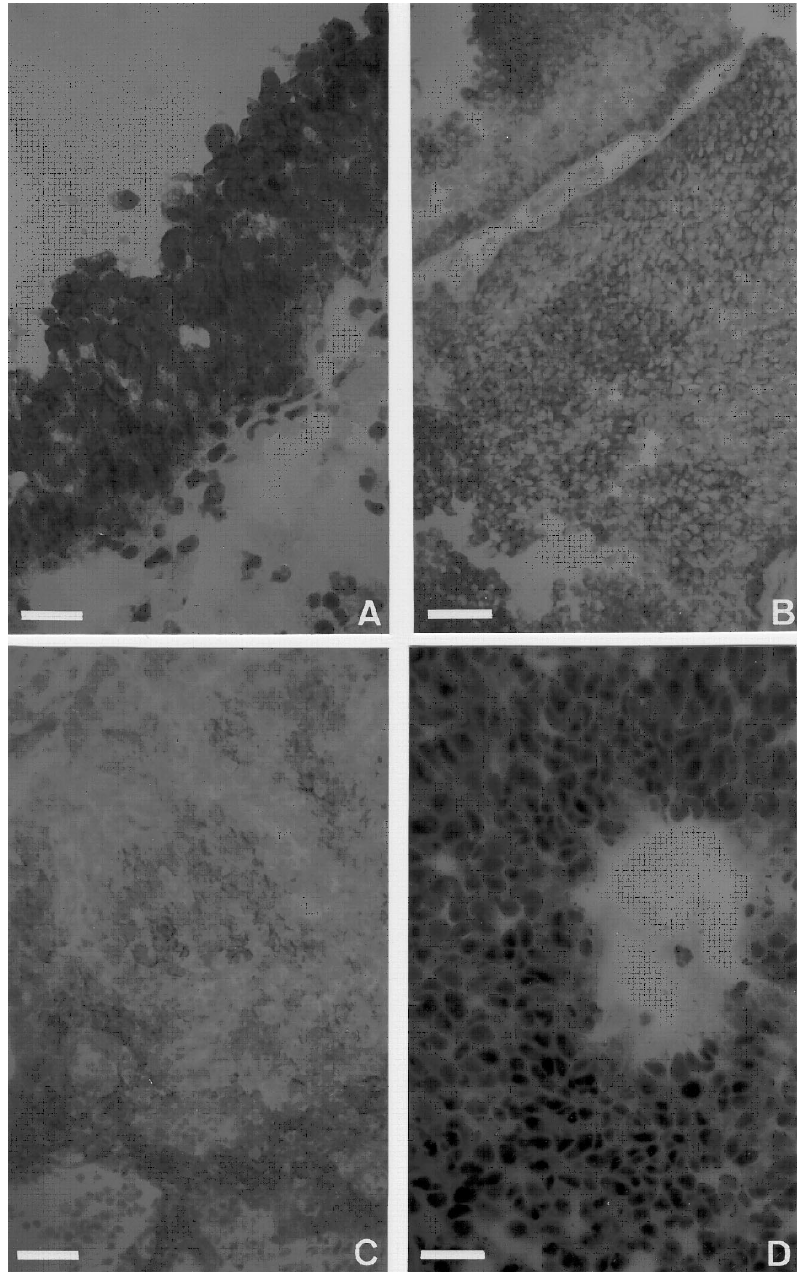
Fig. 2. Immunoreactive E-cadherin expression in normal bladder and cancerous tissues. A) All epithelial cells strongly and homogeneously expressed E-cadherin at cell to cell contacts in normal urothelium. B) Preserved E-cadherin expression in superficial carcinoma. C) Invasive tumour with heterogeneous E-cadherin expression. Some cells were E-cadherin negative whereas the others were normally stained. D) Section of superficial tumour with E-cadherin cytoplasmic staining. (Streptavidin-biotin-phosphatase complex method; A) bar = 12.5 (cid:22) m, (cid:2) 800, B) and C) bars = 50 (cid:22) m, (cid:2) 200 and D) bar = 20 (cid:22) m, (cid:2)